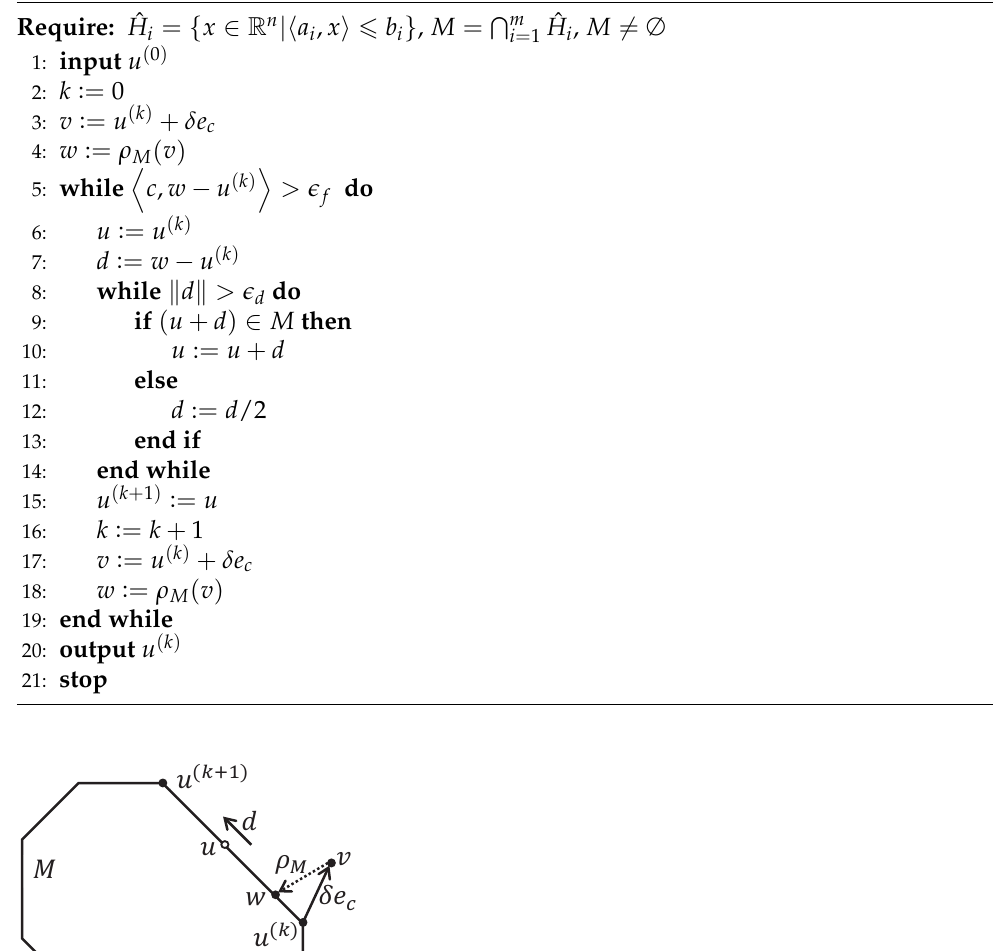
Algorithm 3 Target stage.